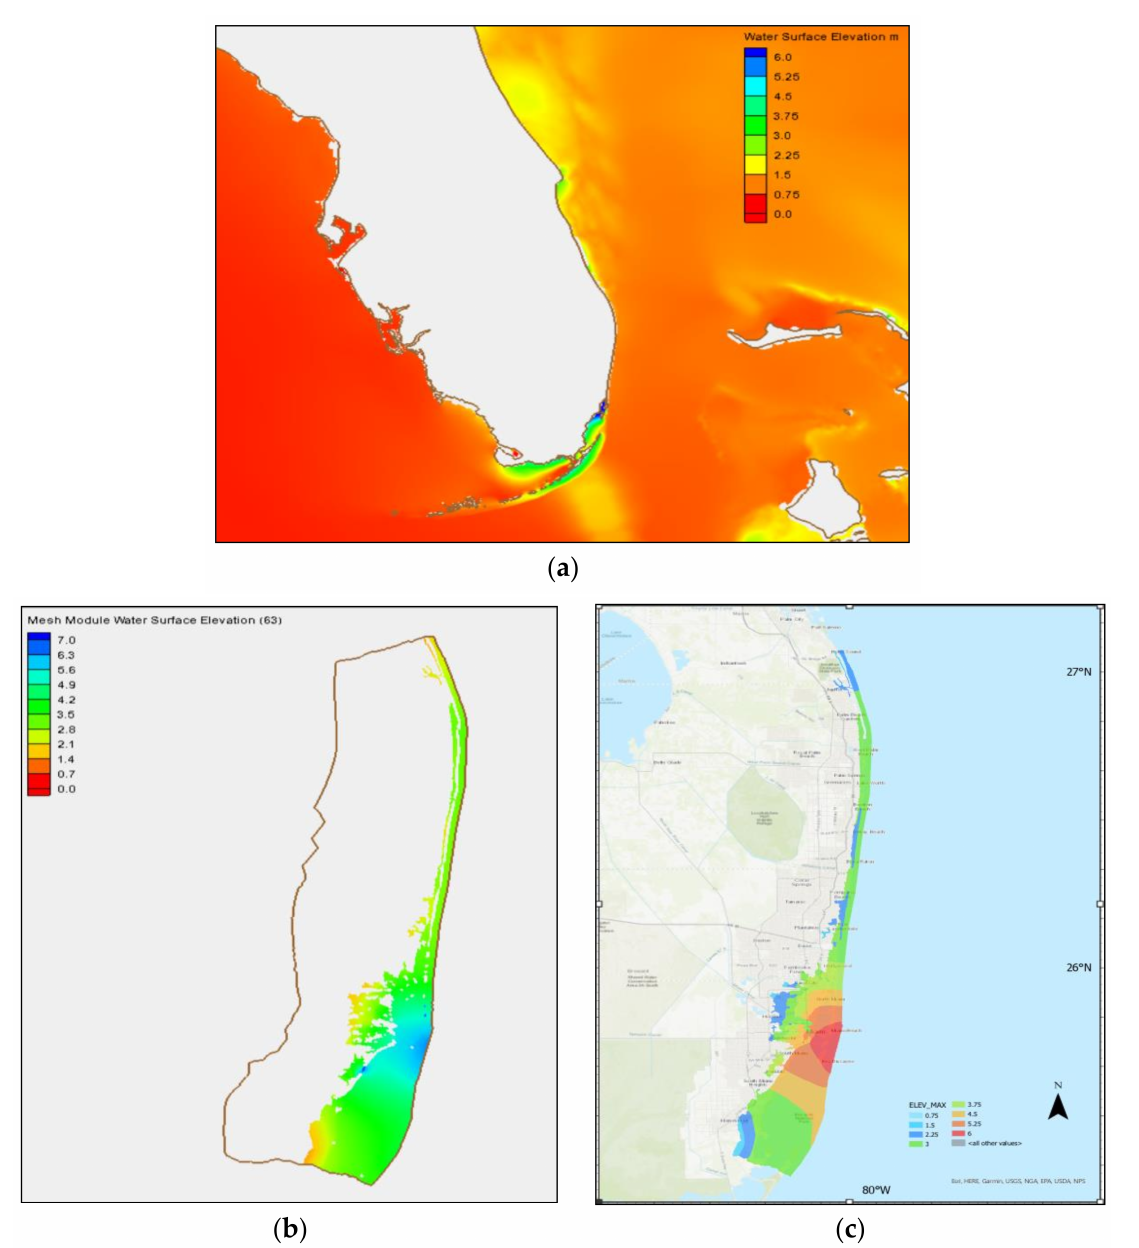
Figure 7. ( a ) Maximum water levels—output from the coupled ADCIRC+SWAN model; ( b ) Water level obtained from the nested inundation model; ( c ) Surge zones from the inundation model using